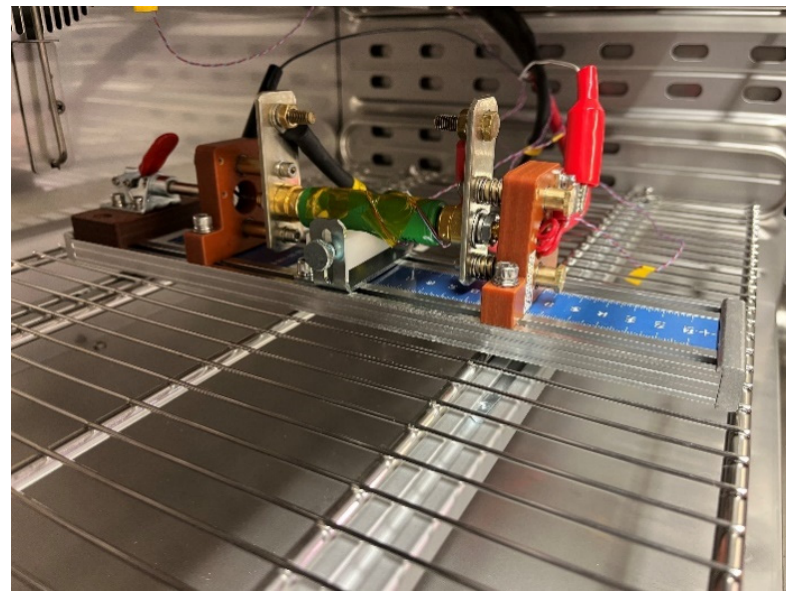
Figure 5. Sony VTC6 cell experimental